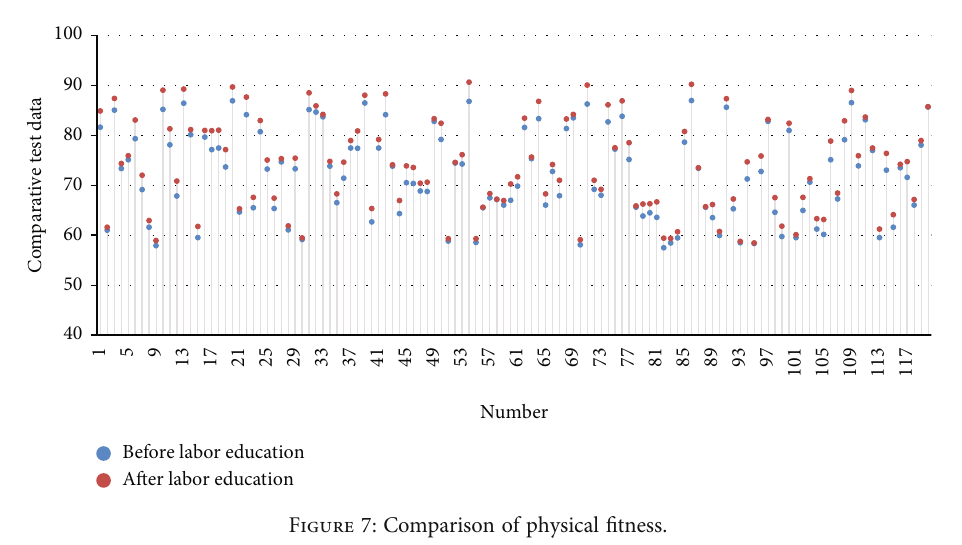
Figure 7: Comparison of physical fi